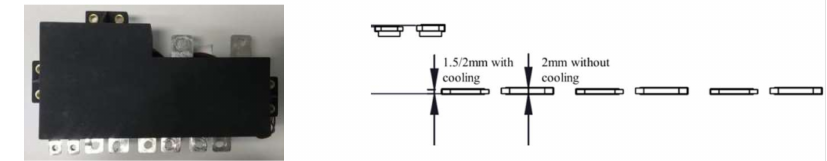
Figure 3. A capacitor with a different busbar.